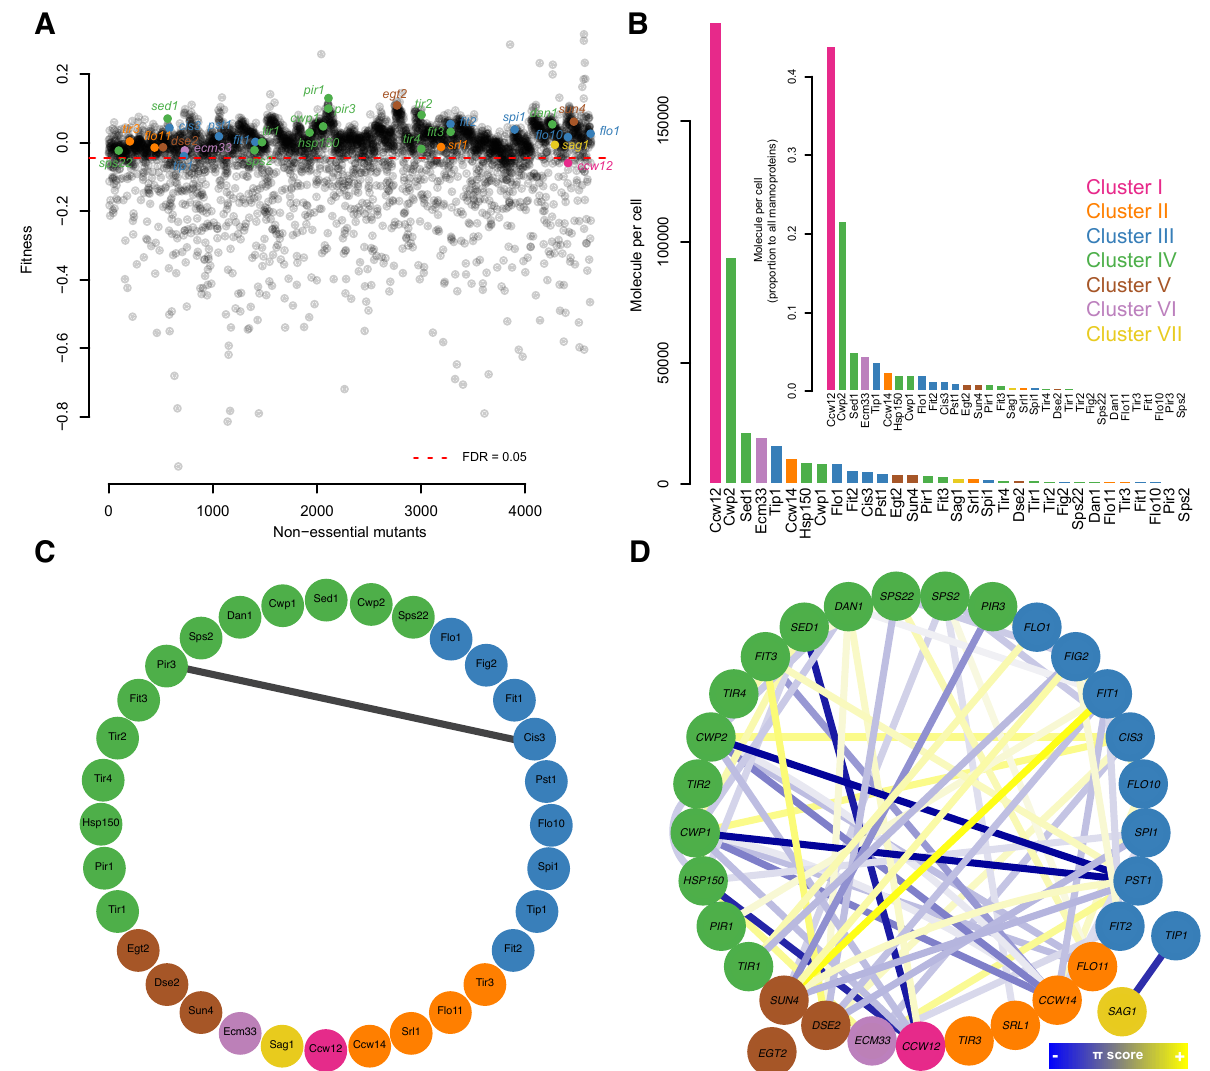
Figure 5. Mannoprotein analyses based on omics studies. ( A ). Scatter plot representing fitness-related defects. The dashed red line indicates a false discovery rate (FDR) of 5%. Data are from Warringer et al. [10]. Fitness data for ccw14 ∆ were not available in the dataset. ( B ). Bar plot showing the average cell wall mannoprotein abundances. Inset: A subset of the data. Data were obtained from [36]. ( C ). Protein–protein interactions among mannoprotein proteins are shown. Black line shows physical interaction. Data are from Oughtred et al. [37]. ( D ). Genetic interactions (GIs) among mannoprotein genes presented as blue (negative GI) or yellow (positive GI) lines ( p < 0.05). Data are from Costanzo et al. [39]. EGT2 did not have any significant GIs. In all sections, mutants are color-coded according to Gaussian mixture model clustering of morphological data (see Figure